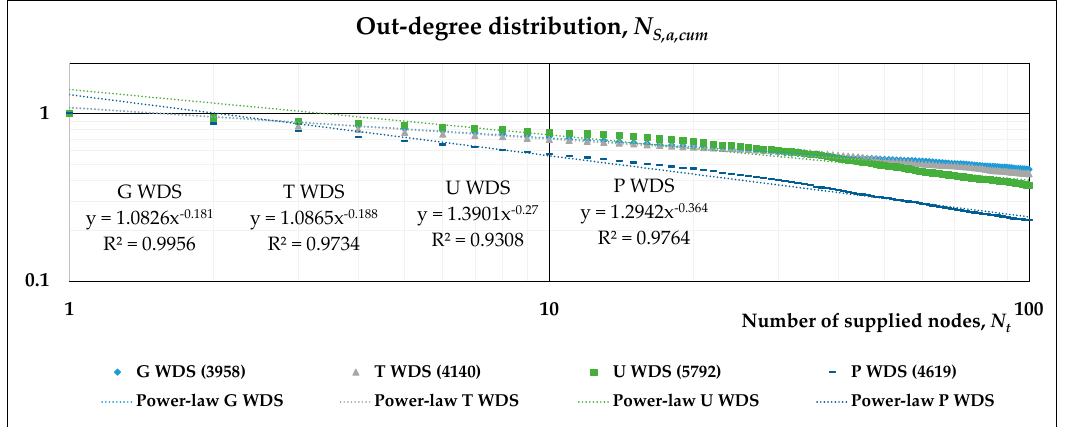
Figure 8. Cumulative out ‐ degree distribution functions limited in the range 100–1000 N t , together with their exponential fitting.